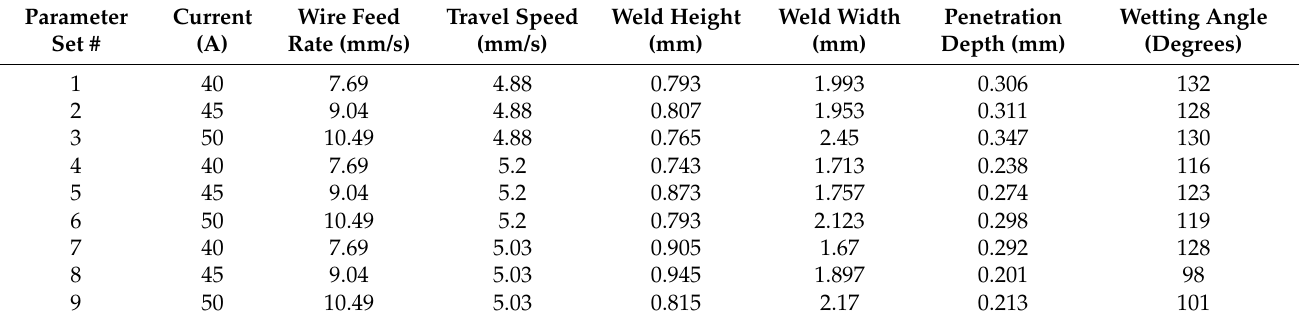
Table 5. Processing parameters and weld bead characteristics for Inconel 718 single pass samples.